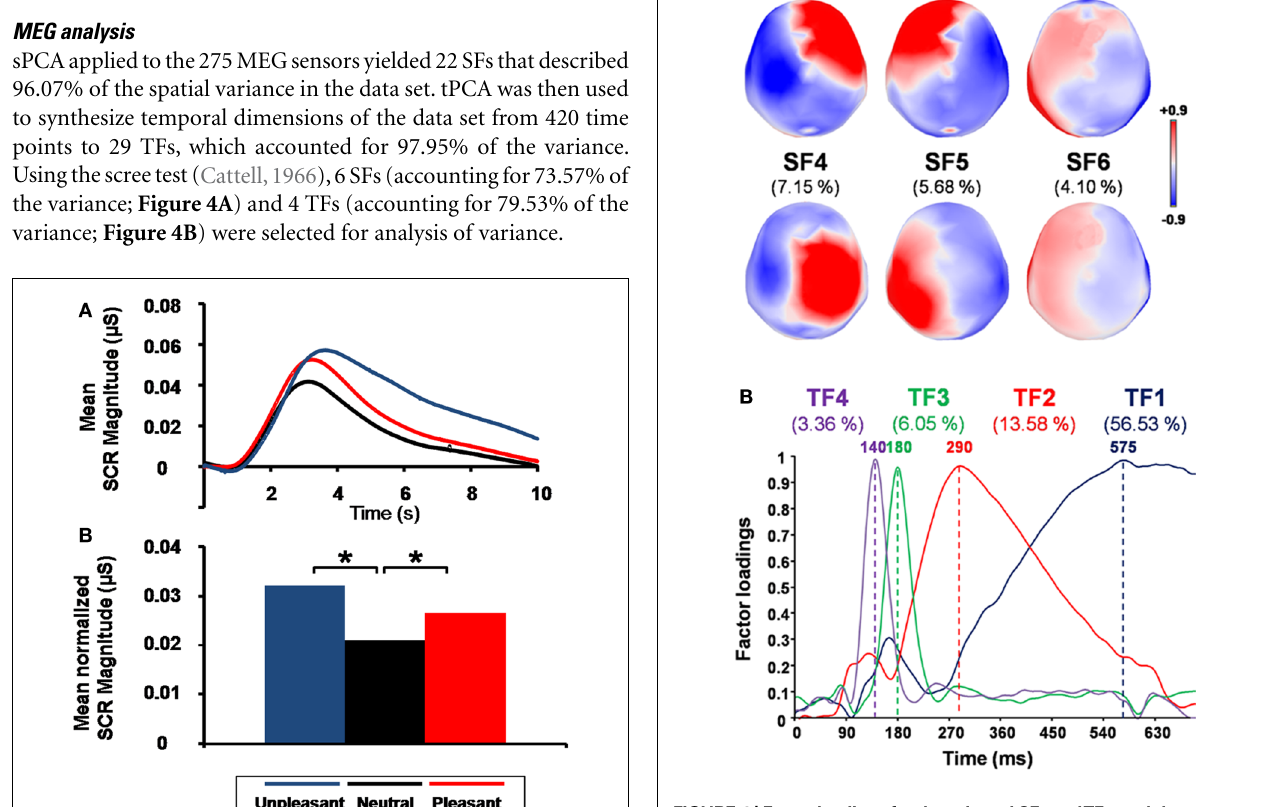
FIGURE 4 | Factor loadings for the selected SFs and TFs, and the corresponding percentage of variance accounted for by each factor. (A) Topographic maps of factor loadings for the selected spatial factors (SFs) as recorded by MEG sensors. (B) Factor loadings of the selected temporal factors (TFs) as a function of